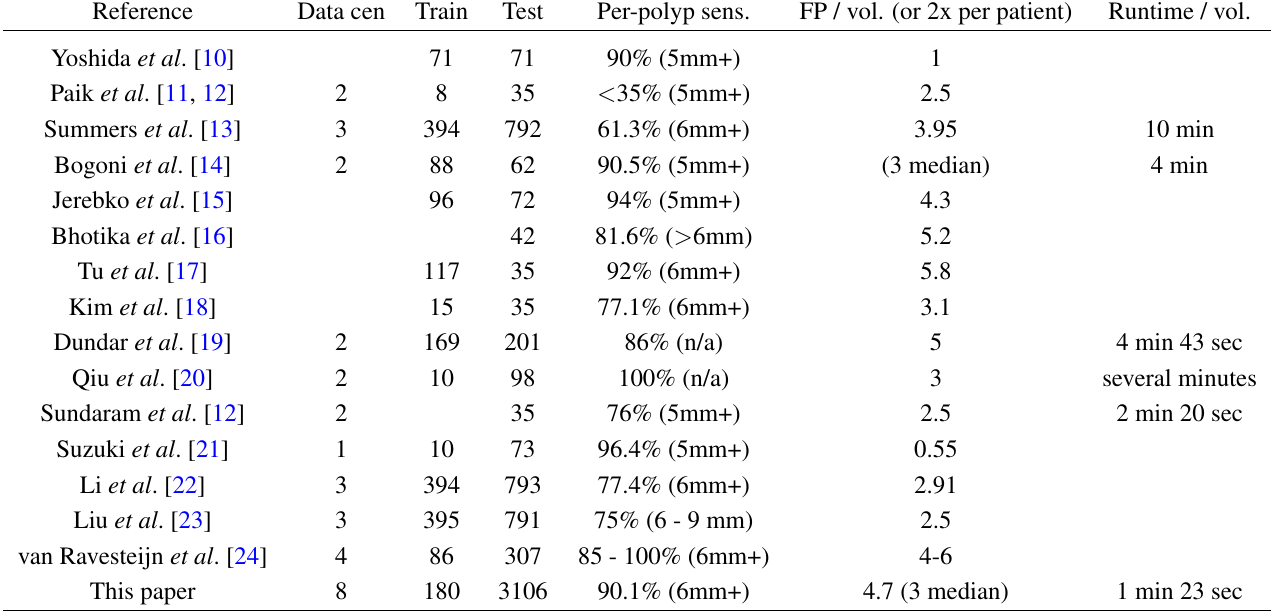
Table 1. CTC-CAD results reported in the literature. From left to right: columns refer to the reference, number of different data centers from which the data came, number of patients used in training, number of patients used in testing, per polyp sensitivity, false positives per volume (per patient false positive rates can be determined by multiplying the per volume false positive rate by 2 ), and algorithm runtime per